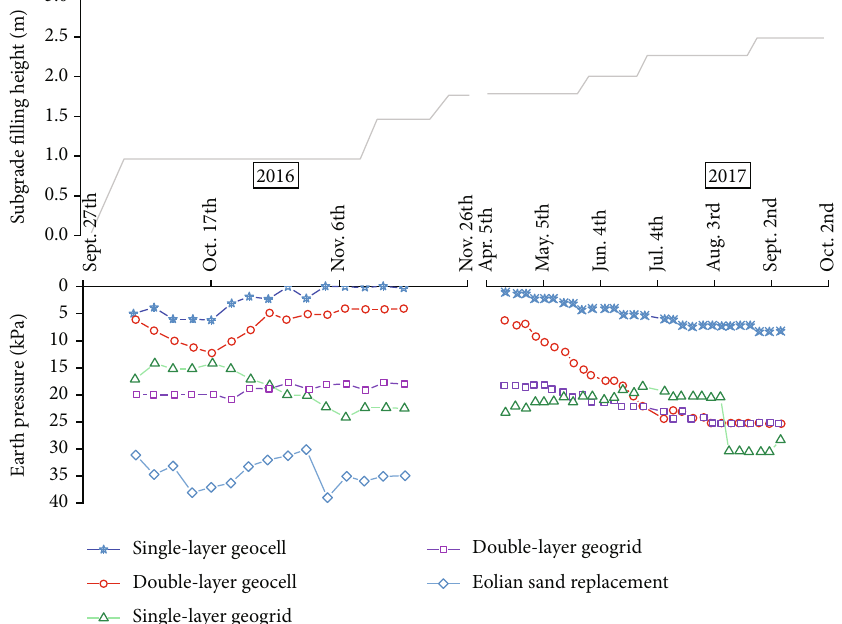
Figure 7: Soil pressure-time curve of the subgrade in the middle